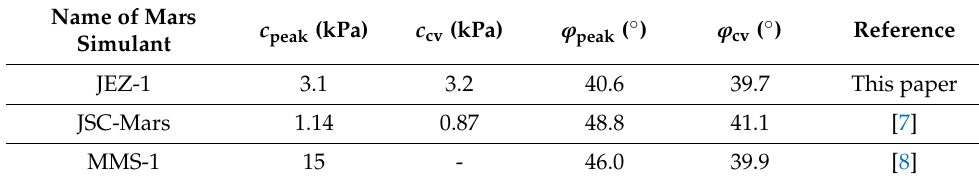
Figure 7. Peak and residual failure envelopes from direct shear tests of JEZ-1. Table 4. Cohesion and internal friction angle of Mars